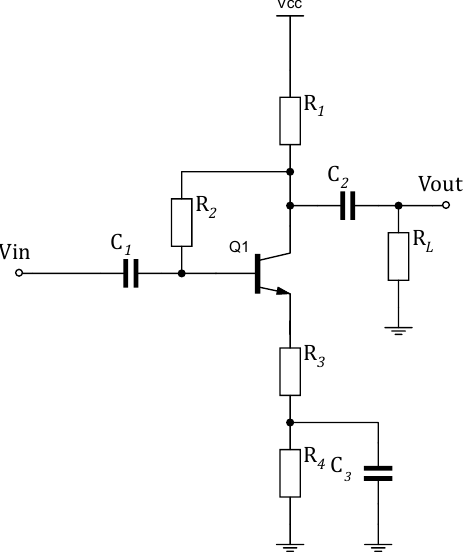
Figure 8. Baseband amplifier (BBAMP) configured as a common-emitter bipolar junction transistor (BJT) with collector-feedback